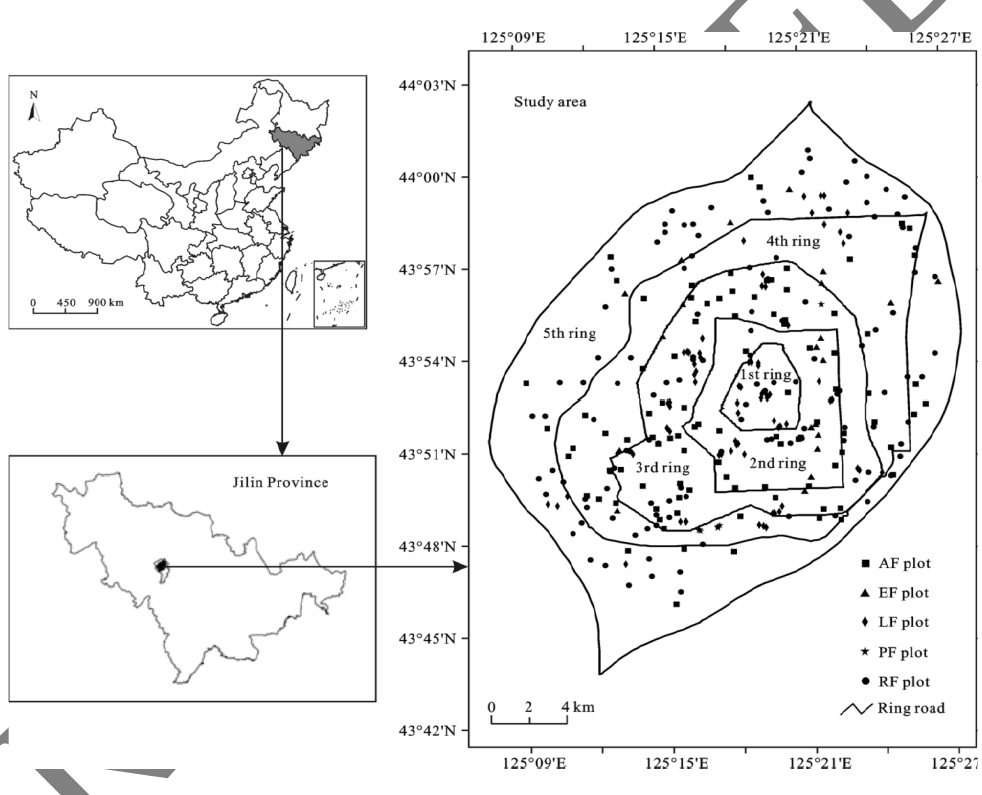
Figure 1. The study area located within the fifth-loop road in the City of Changchun, China. AF: attached forest; EF: ecological and public welfare forest; LF: landscape and relaxation forest;